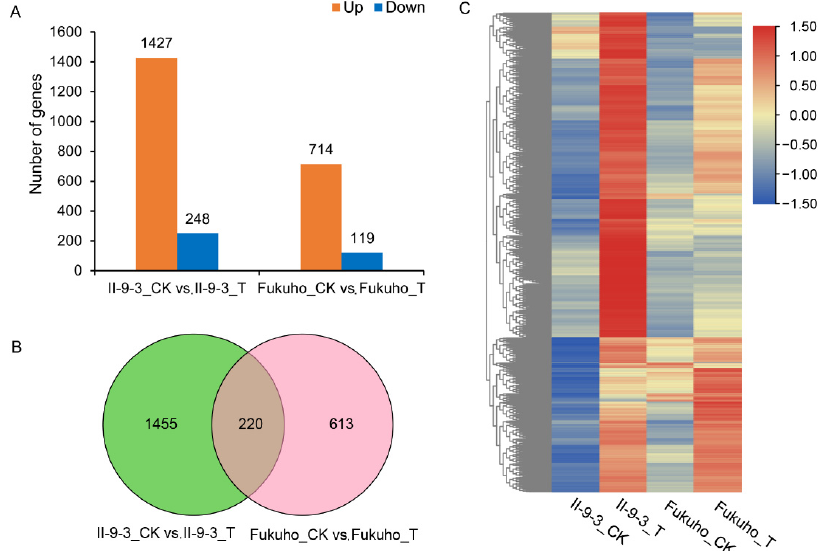
Figure 3. Analysis of DEGs of the addition line II-9-3 and Fukuho before and after inoculation: ( A ) Number of DEGs; ( B ) Venn diagram of DEGs before and after inoculation; ( C ) Heatmap of DEGs of each sample.